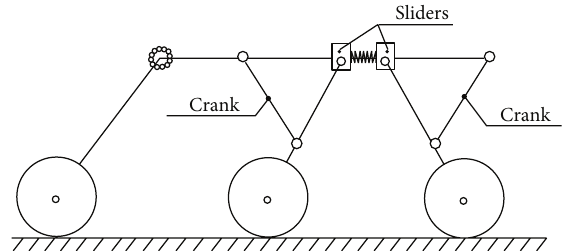
Figure 1: The rocker bogie mobile system.